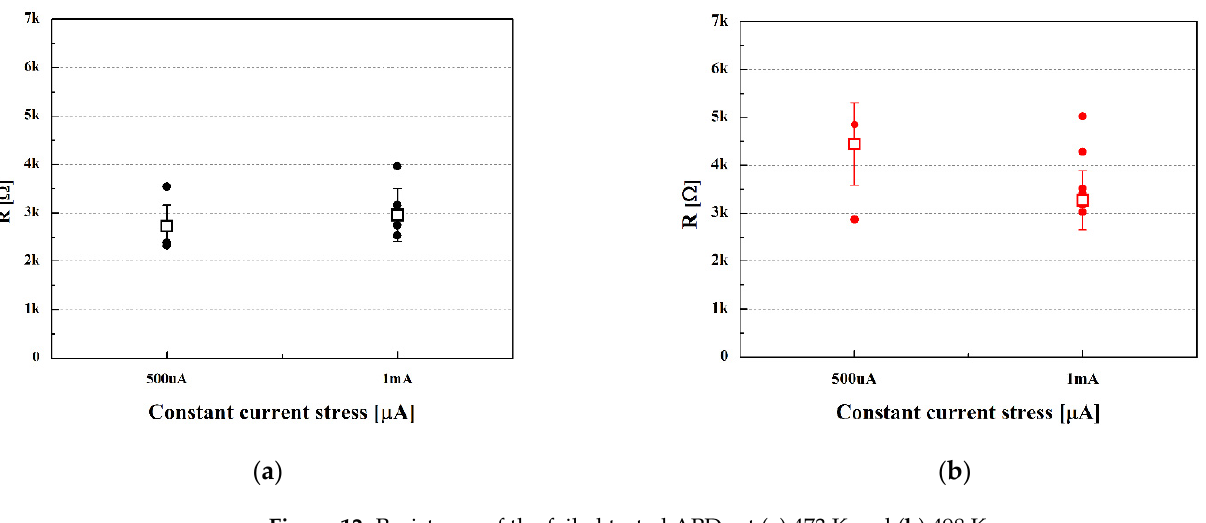
Figure 12. Resistance of the failed tested APDs at ( a ) 473 K and ( b ) 498 K. Table 3 . Resistance of the failed tested APDs.